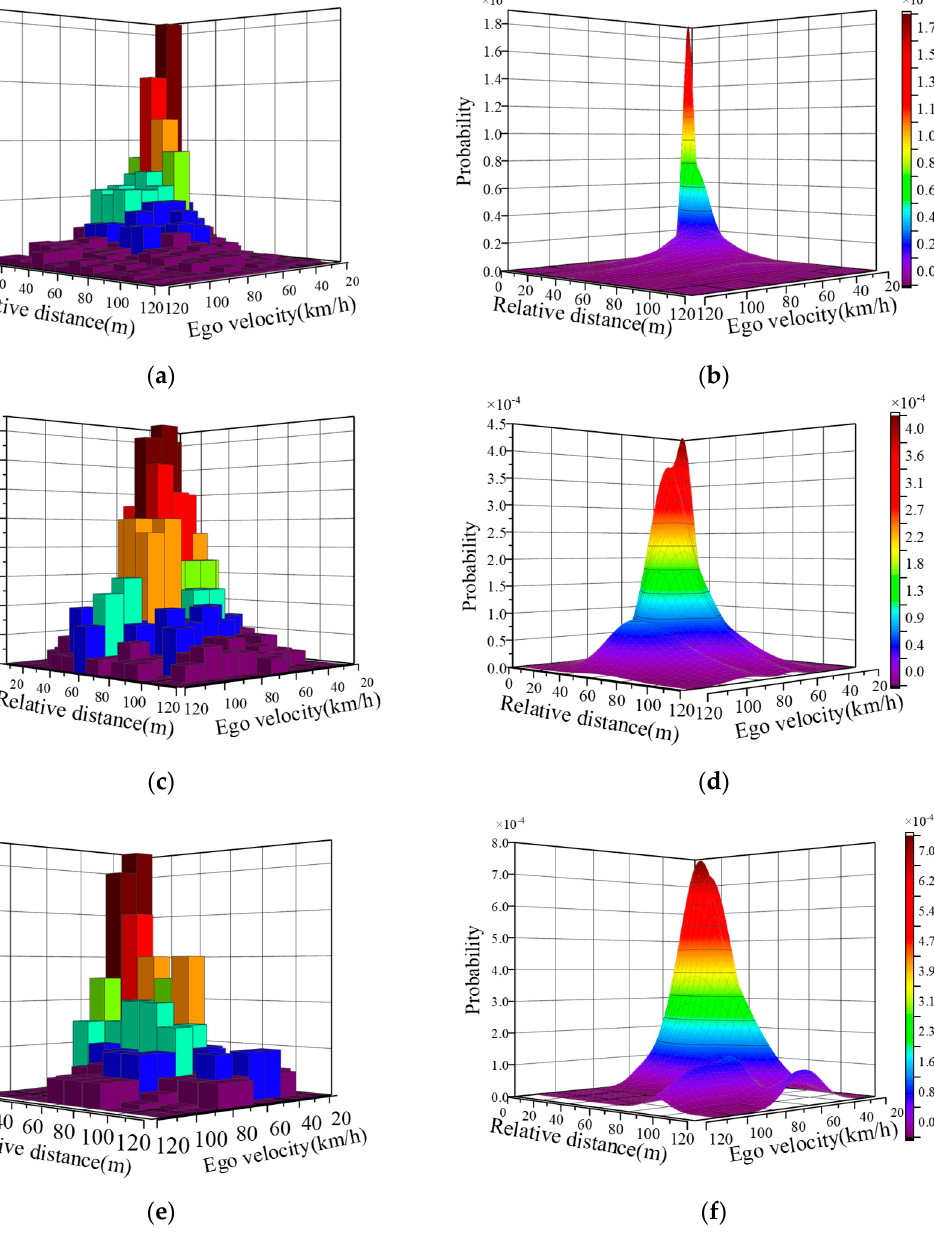
Figure 4. Comparison of raw data and Gaussian mixture model. ( a ) Car: raw data, ( b ) Car: Gaussian mixture model, ( c ) Bus: raw data, ( d ) Bus: Gaussian mixture model, ( e ) Truck: raw data, ( f ) Truck: Gaussian mixture model.